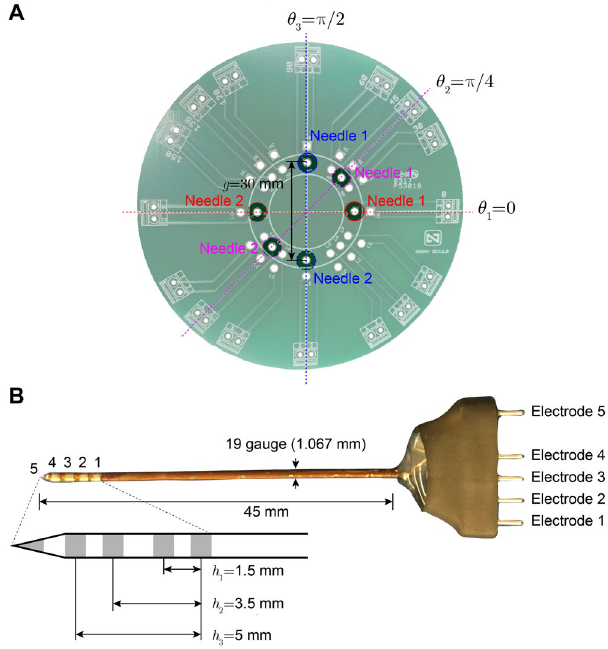
Figure 10. Printed circuit board ( A ) 17 and multipolar needle ( B ) 36 used for performing in situ measurements of ovine ex vivo muscle. The needles integrate a total of five electrodes, four electrodes arranged along the shaft of the needle, and a fifth, at the tip of the needle. Electrode 5 was not used in this study. The reader is referred to Table 2 for the measurement details.